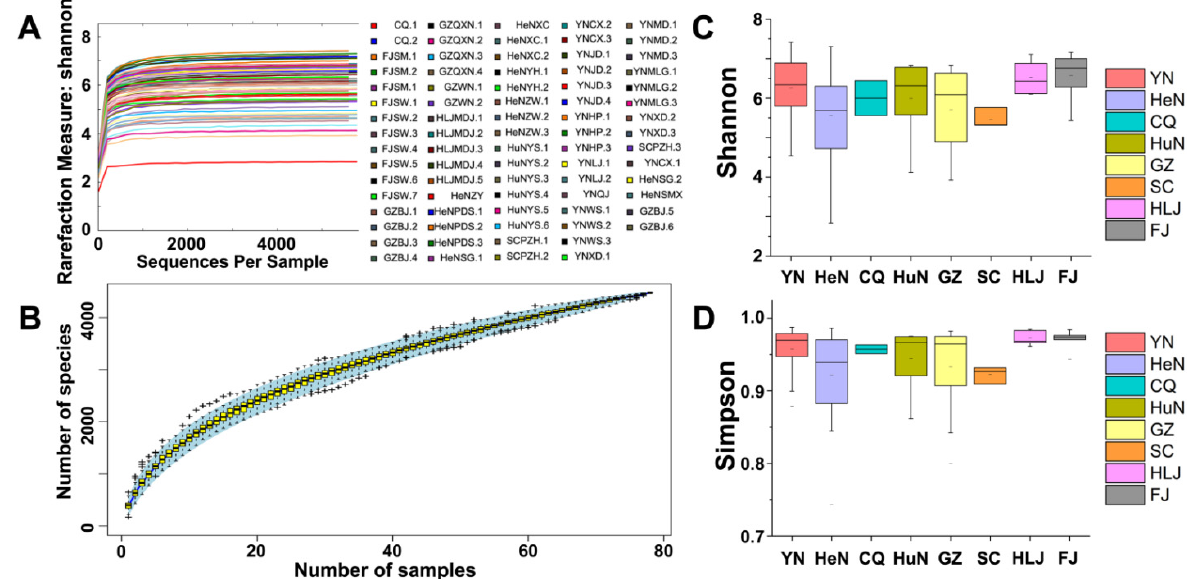
Figure 2. α -diversity analysis. ( A ) The Shannon rarefaction curves of 78 samples. The curve has reached a plate stage, indicating that the sequencing depth of the samples is suitable for further study. ( B ) Species accumulation curves of 78 samples. The curve tended to be flat, indicating that the bacterial richness of the 78 samples is sufficient for further analysis. ( C , D ) Box plots of the Shannon and Simpson index values of YN, HeN, CQ, HuN, GZ, SC, HLJ, and FJ province, respectively. Microbial diversity was highest in Fujian province and lowest in Henan province.